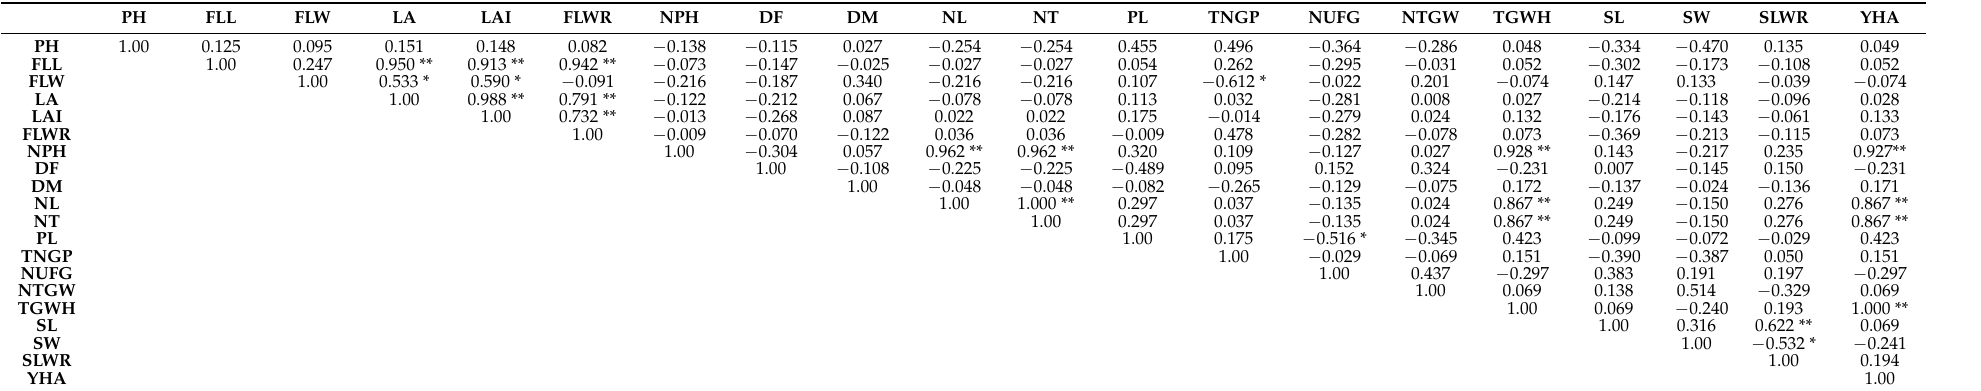
Table 7. The Pearson correlation coefficients (r) among quantitative traits of selected